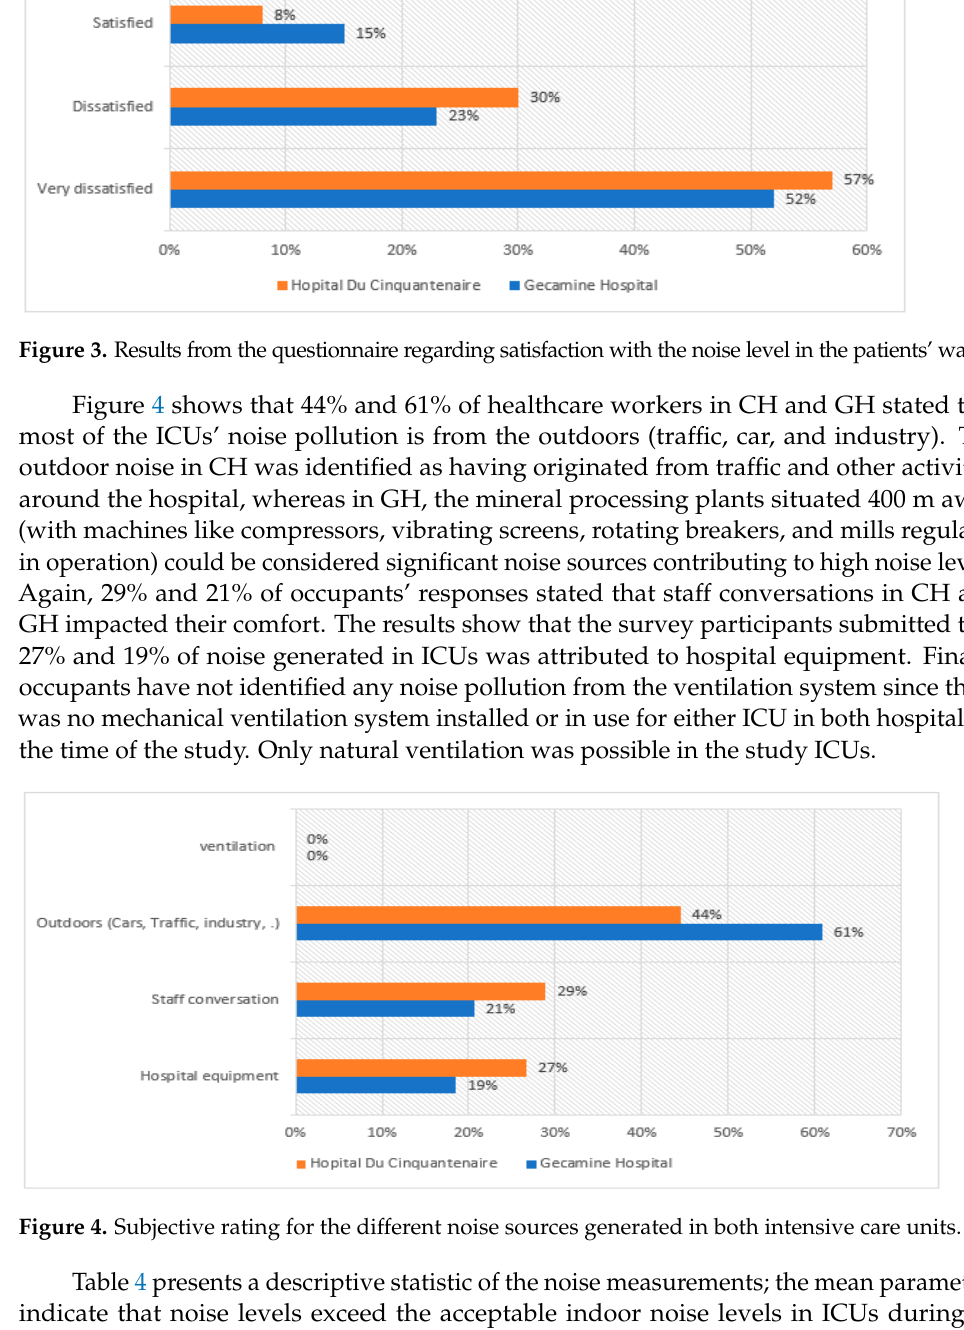
indicate that noise levels exceed the acceptable indoor noise levels in ICUs during all assessed periods and days. The noise level measurements are normal distribution. Only ANOVA has been used to evaluate these three data sets of L den Table 4. Descriptive statistics of experimental noise level measurements in both ICUs for all days considering the day, evening, and night periods.